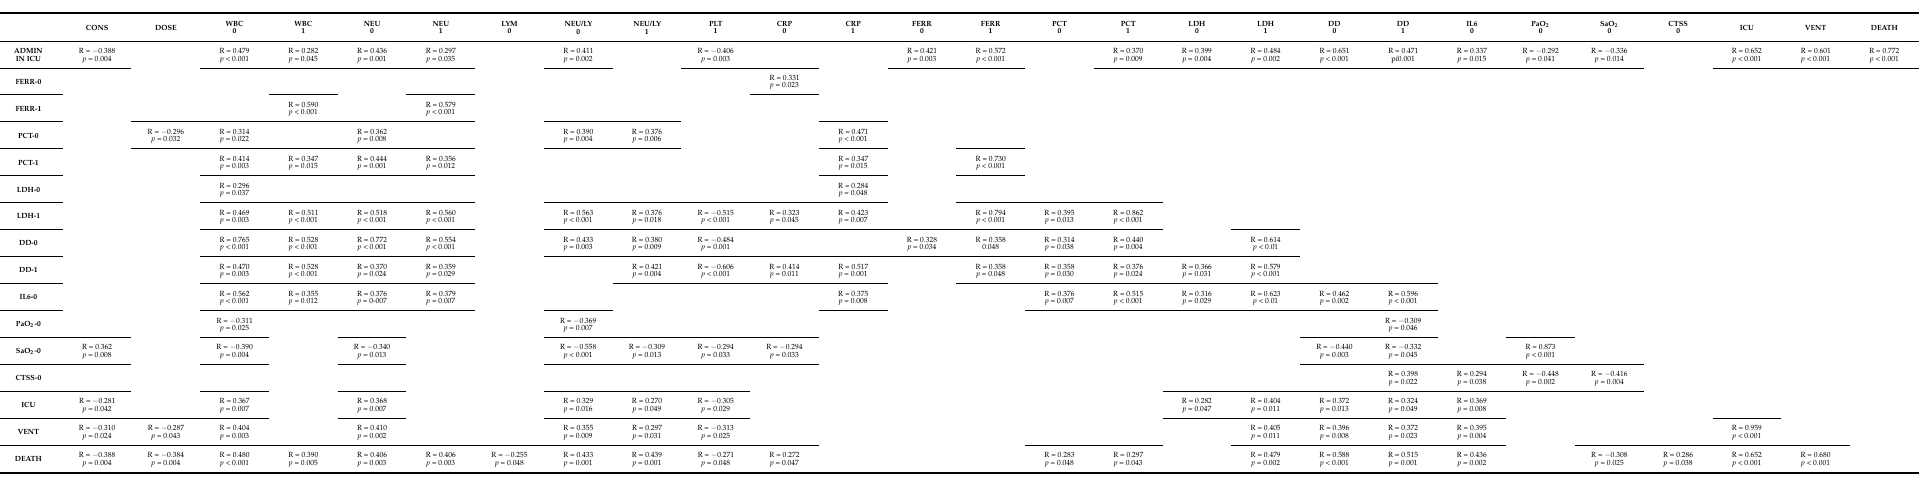
Table 3. Significant correlations between various parameters in the TCZ-treated and the control groups. * TCZ-treated